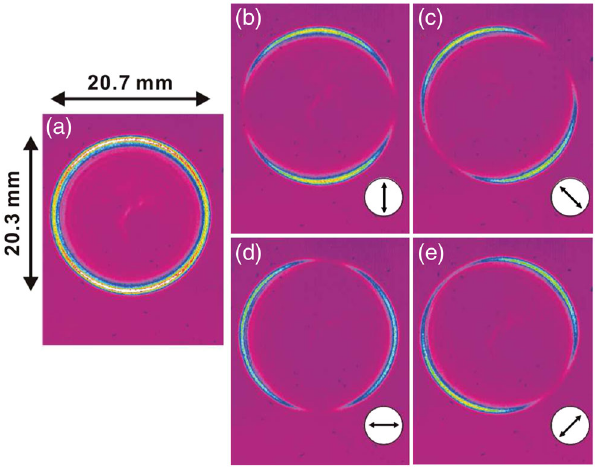
FIG. 6. Radially polarized laser with anti-Gaussian profile (hollow beam) after axicon lens pair without (a) and with (b)–(e) polarizers. Arrows represent polarization directions.